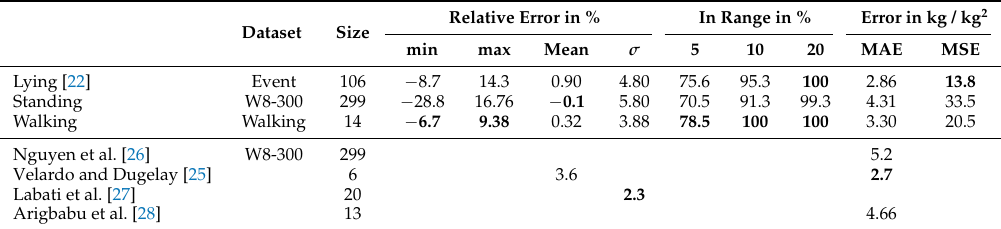
Figure 10. Comparison between the different settings for body weight estimation: Although the results for the estimation with standing people from the W8-300 dataset is the worst in this cumulative plot, the results can be sufficient for a certain applications. Due to the clustering approach, the estimation of walking subjects outperforms the other settings within the range of ± 5 percent. The results for the lying patients are taken from Pfitzner et al. [22]. Table 7. Results from experiments for standing and walking people. Additionally, the results from Pfitzner et al. [22] are added for comparison. The lower part of the table illustrates the results from related work, when available in detail. The best result is marked in bold for each